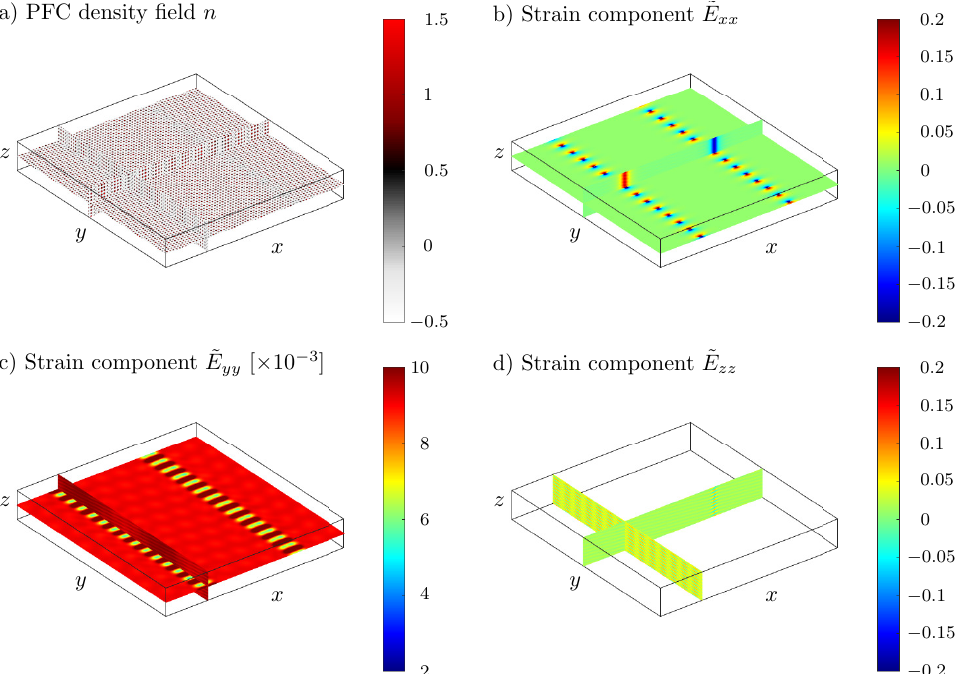
Figure 10. ( a ) PFC density field n ( r ) , shown on three orthogonal planes through the 3D simulation domain. Figures ( b – d ) show examples of strain components obtained by GPA applied to the PFC results. The strain components are shown on the same planes as indicated in figure ( a ); ( b ) Strain component ˜ E xx ; ( c ) Strain component ˜ E yy ; ( d ) Strain component ˜ E zz . Note the different scale of the color legend in figure ( c ), compared to those in figures ( b , d